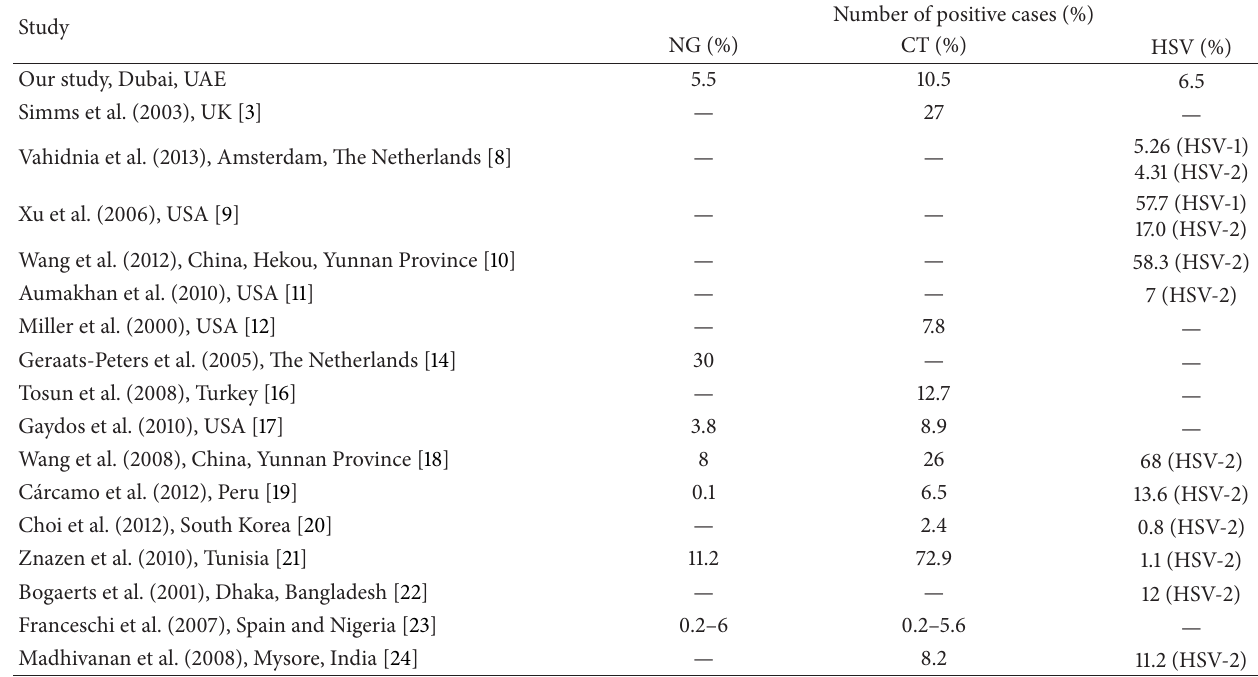
Table 3: Comparison of our data in Dubai, UAE, for prevalence of Herpes simplex virus (HSV), Chlamydia trachomatis (CT), and Neisseria gonorrhoeae (NG) with different